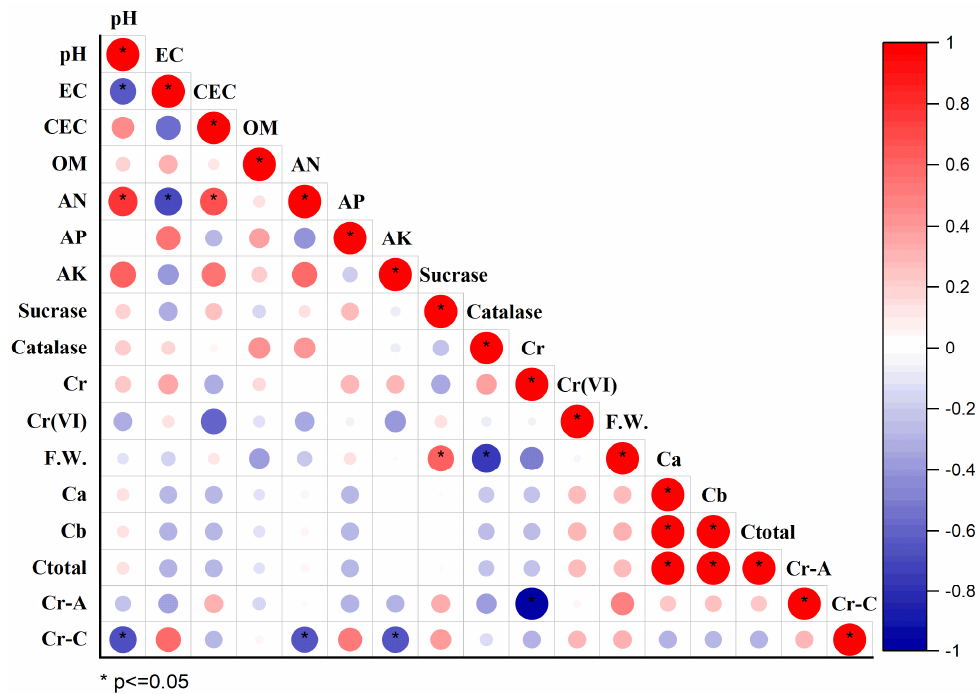
Figure 5. Correlation analysis of basic physicochemical properties, enzyme activities, Cr bioavailability in rhizosphere soil and Cr bioaccumulation in plant. Cr: soil total Cr content, Cr (VI): soil Cr (VI) content, F.W.: fresh weight, Ca: chlorophyll a, Cb: chlorophyll b, Ctotal: total chlorophyll, Cr-A: Cr accumulation in shoot, Cr-C: Cr concentration in shoot.